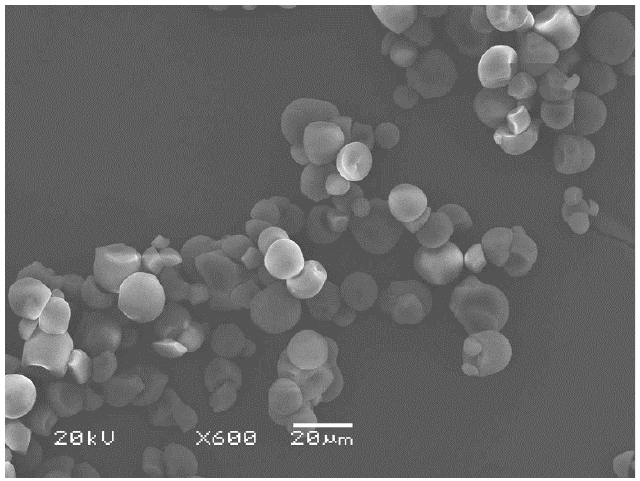
Figure 1. SEM image of cassava starch (bar scale = 20 µm).